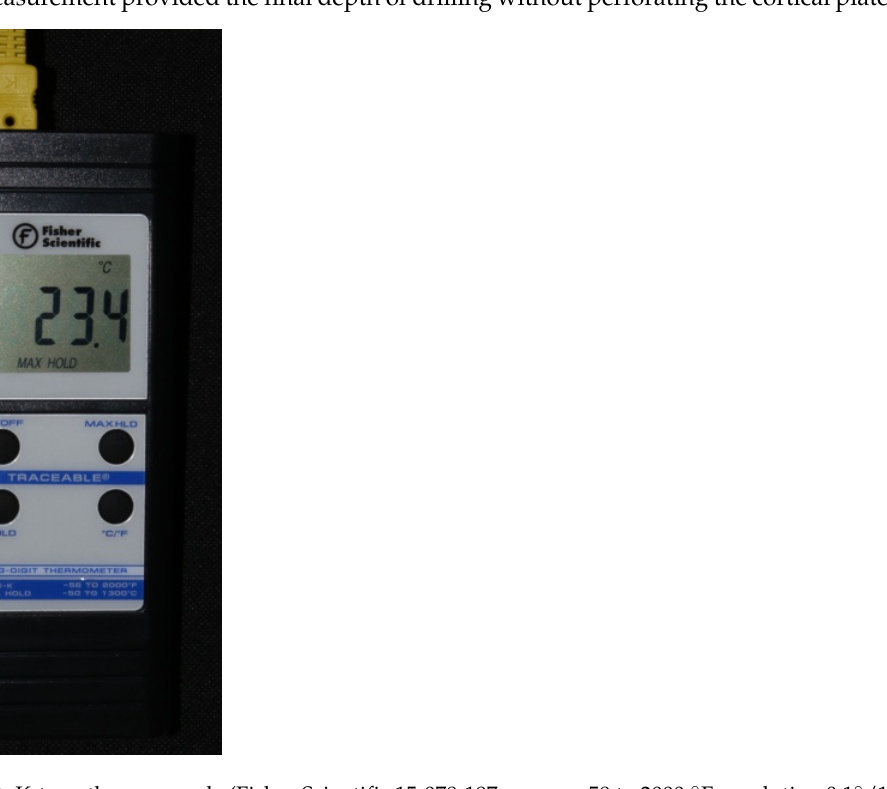
Figure 2. K-type thermocouple (Fisher Scientific 15-078-187, range − 58 to 2000 °F, resolution 0.1°/1°, sampling rate 2.5 times per second) with an ultra-fast response naked bead probe (maxi- mum range 260 °C) which was used to measure the temperature.